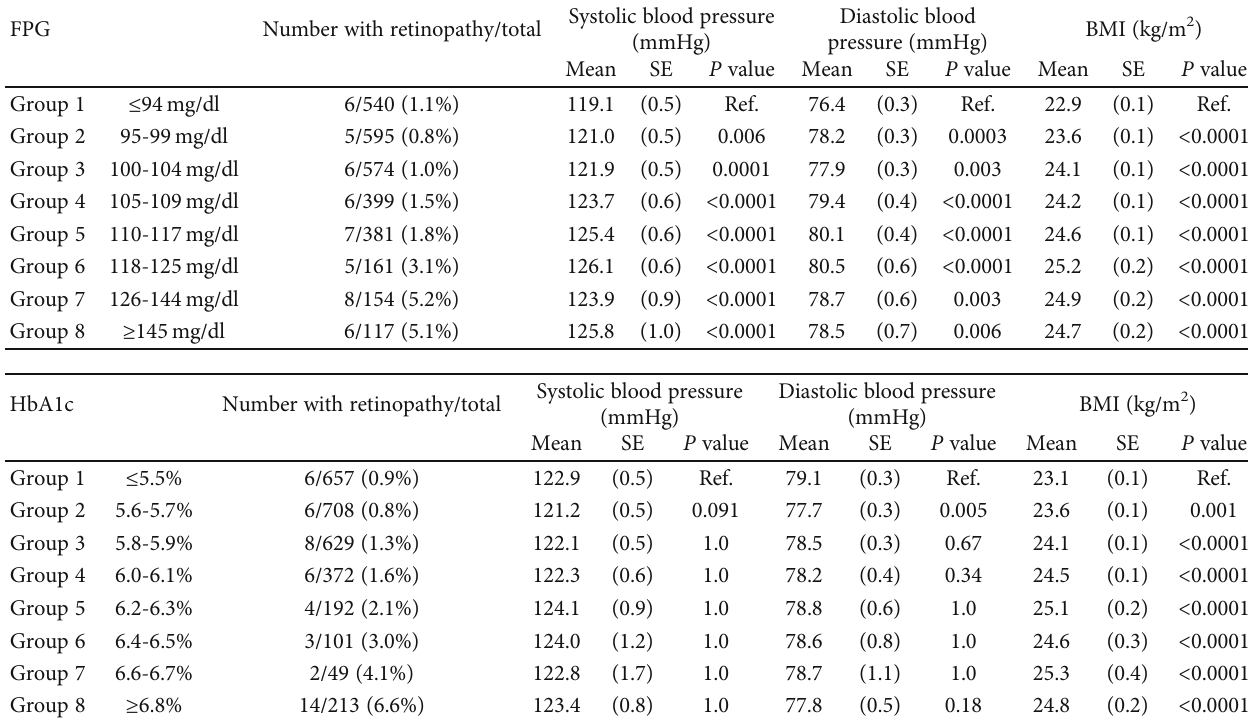
Table 1: Comparison of the clinical characteristics of the subjects in the FPG and HbA1c groups ( n = 2,921 ).